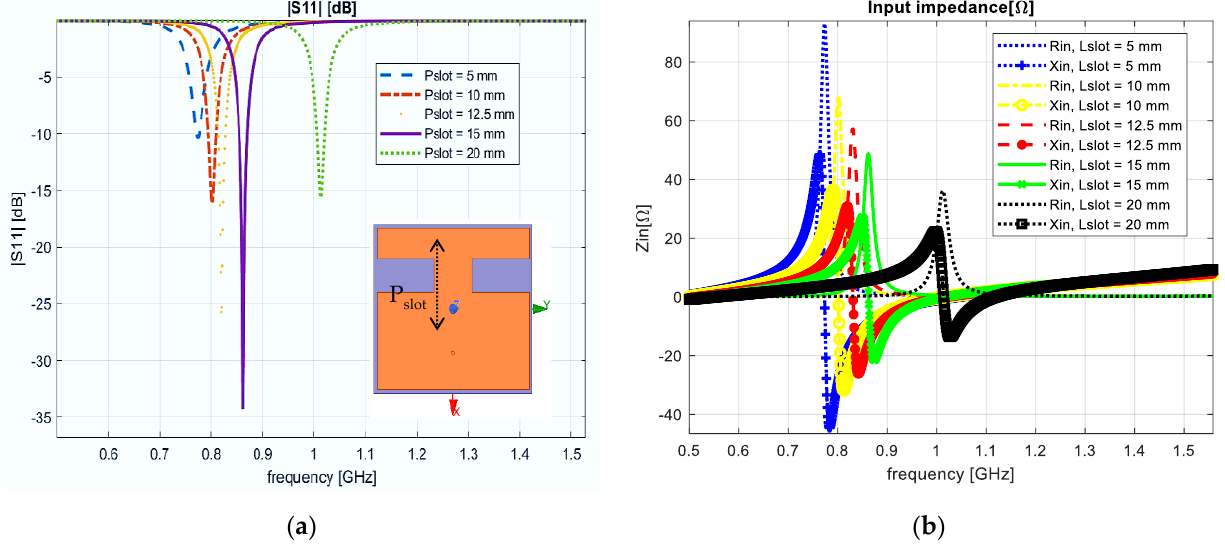
Figure 5. Patch antenna with two notches. The slot position is moved along the x axis. ( a ) Reflection coefficient; ( b ) input